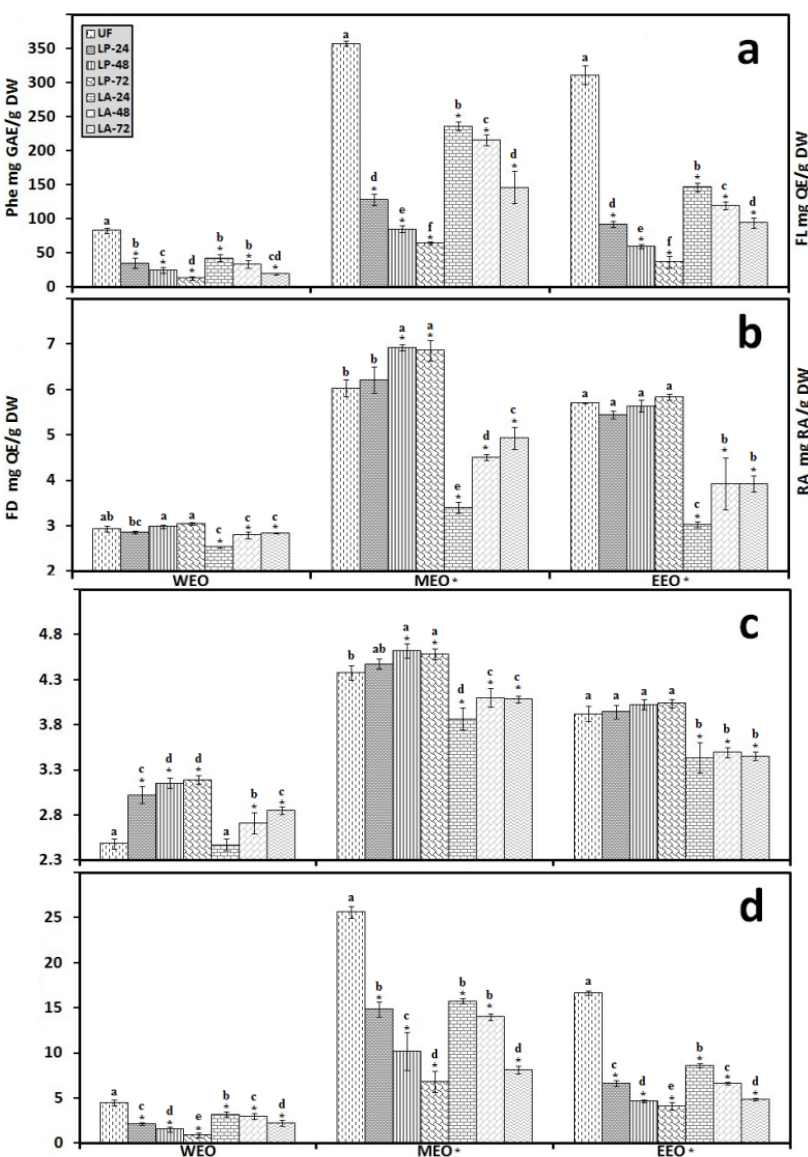
Figure 7. Antioxidant components of IOSC subjected to SSF using three different